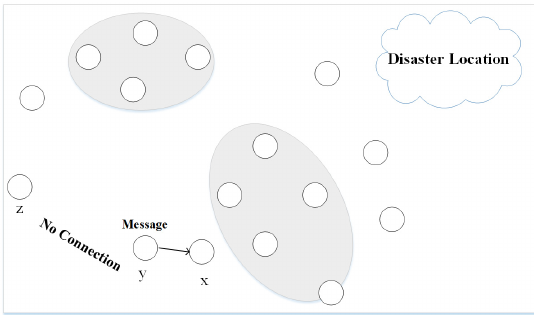
Figure 4. Opportunistic message forwarding.